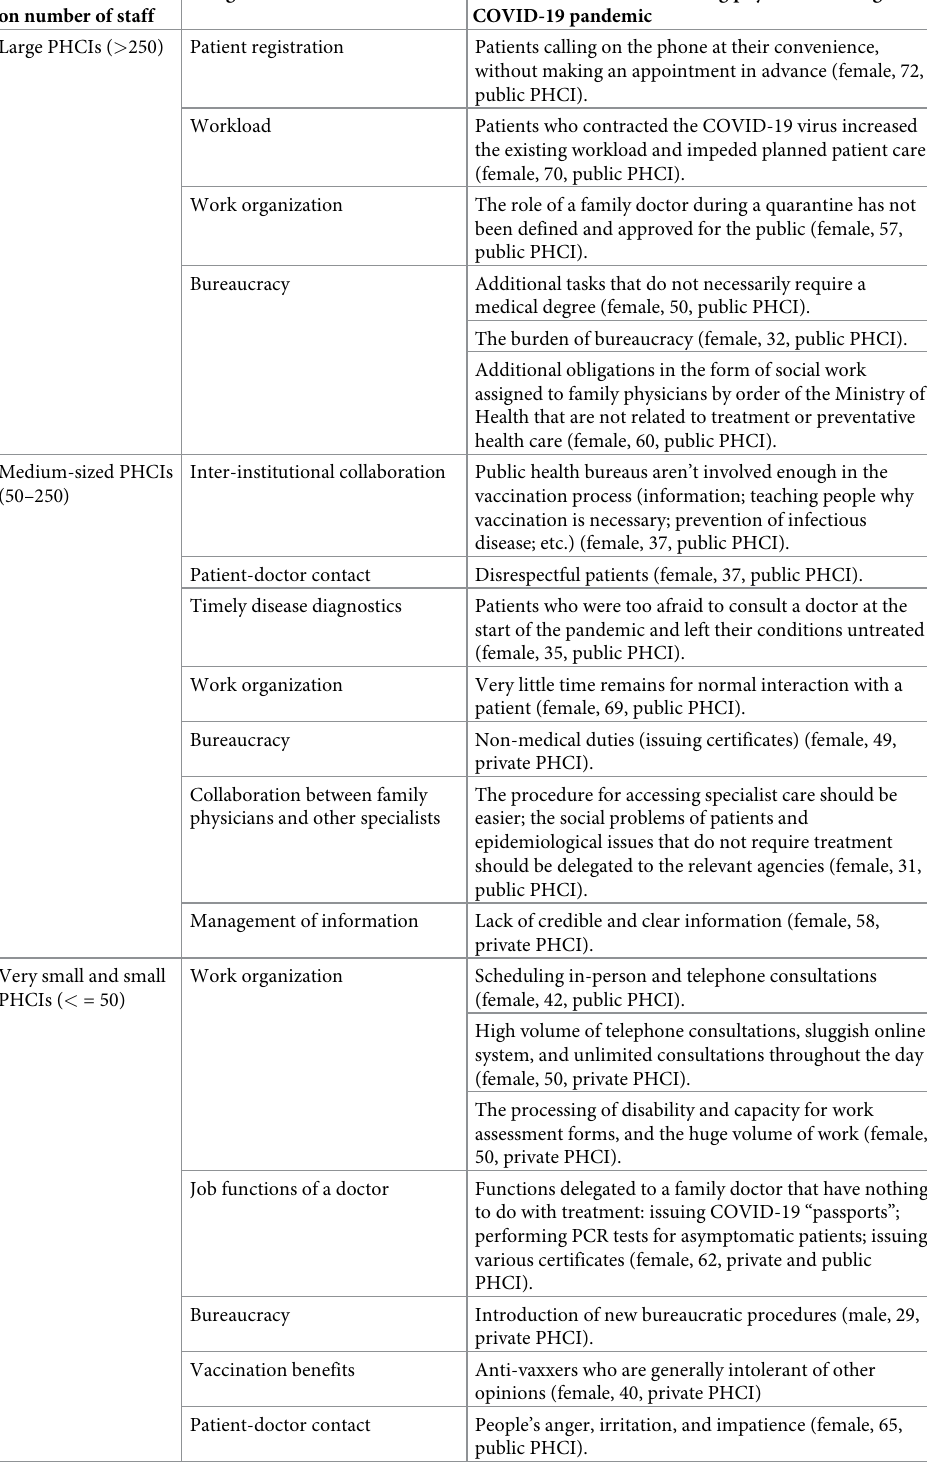
Table 3. The qualitative analysis of the reasons for exhaustion among physicians during the COVID-19